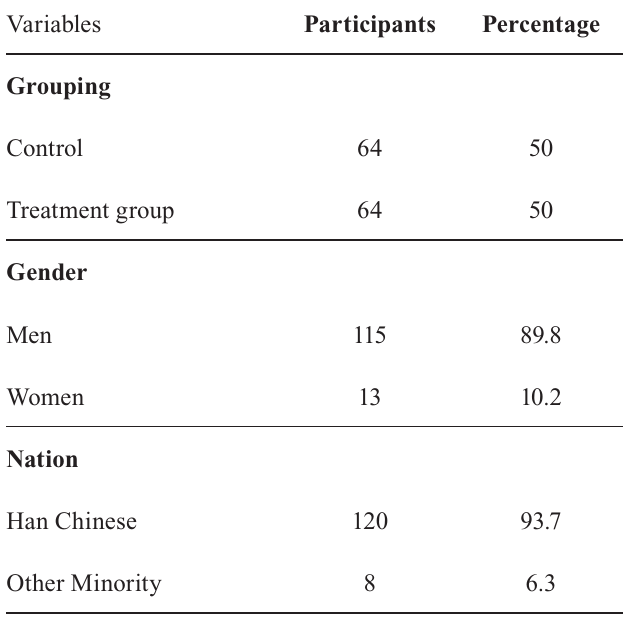
TABLE I - D emographic characteristics of